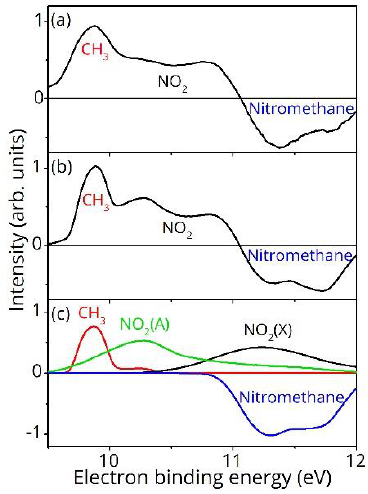
Figure 5. ( a ) TRPES spectrum of nitromethane at τ = 1000 fs. ( b ) Reproduced spectrum using a linear combination of four static photoelectron spectra [nitromethane, CH 3 , NO 2 (X), and NO 2 (A)]. ( c ) Individual contributions in ( b ).